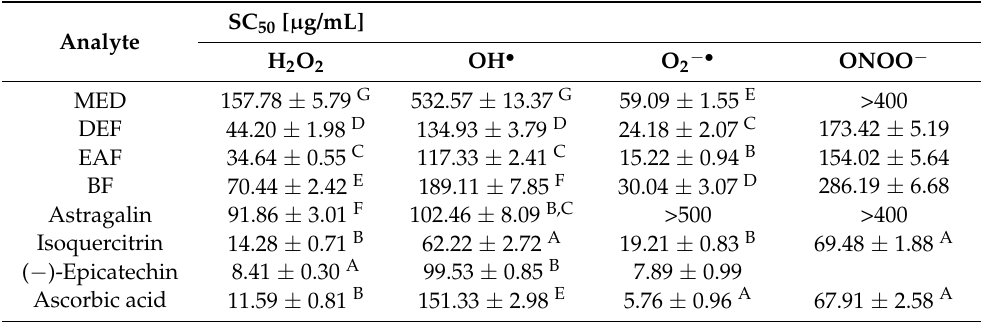
Table 3. Scavenging activity of the dry extracts from the flower of A. hippocastanum towards selected reactive oxygen